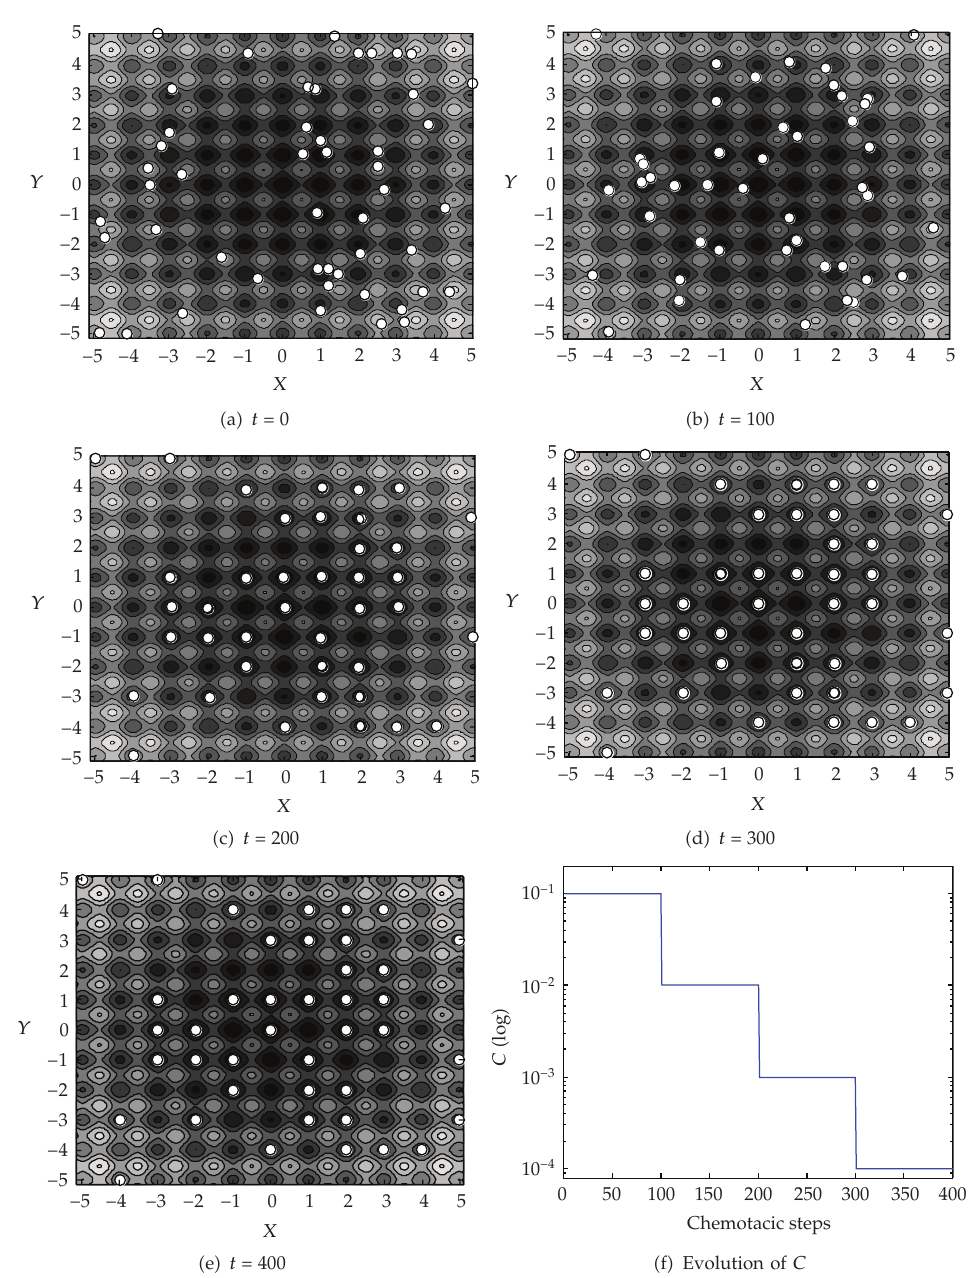
Figure 6: Population evolution of CBFO on 2D Rastrigrin function in 400 chemotactic